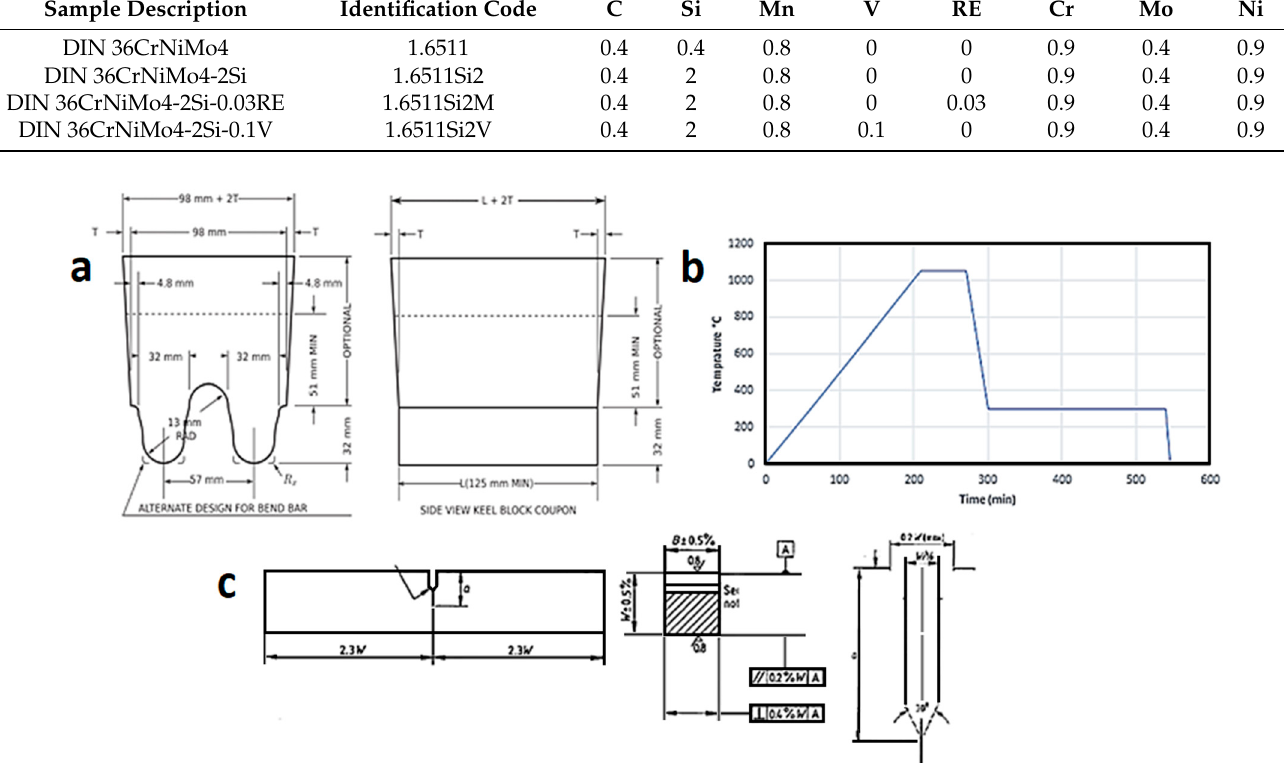
Figure 1. ( a ) Schematic of the keel blocks; ( b ) heat-treatment process cycle; and ( c ) CTOD samples